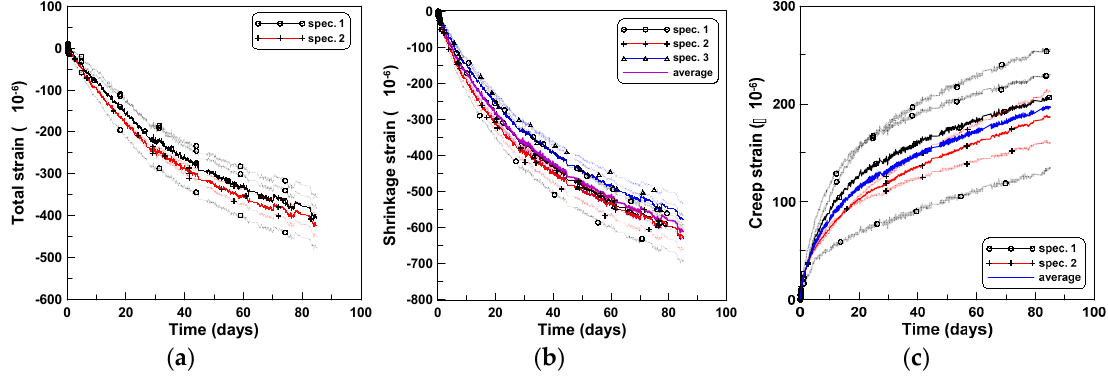
Figure 4. Tension creep tests of test series TP-2: ( a ) total strain, ( b ) shrinkage strain, and ( c ) creep strain.